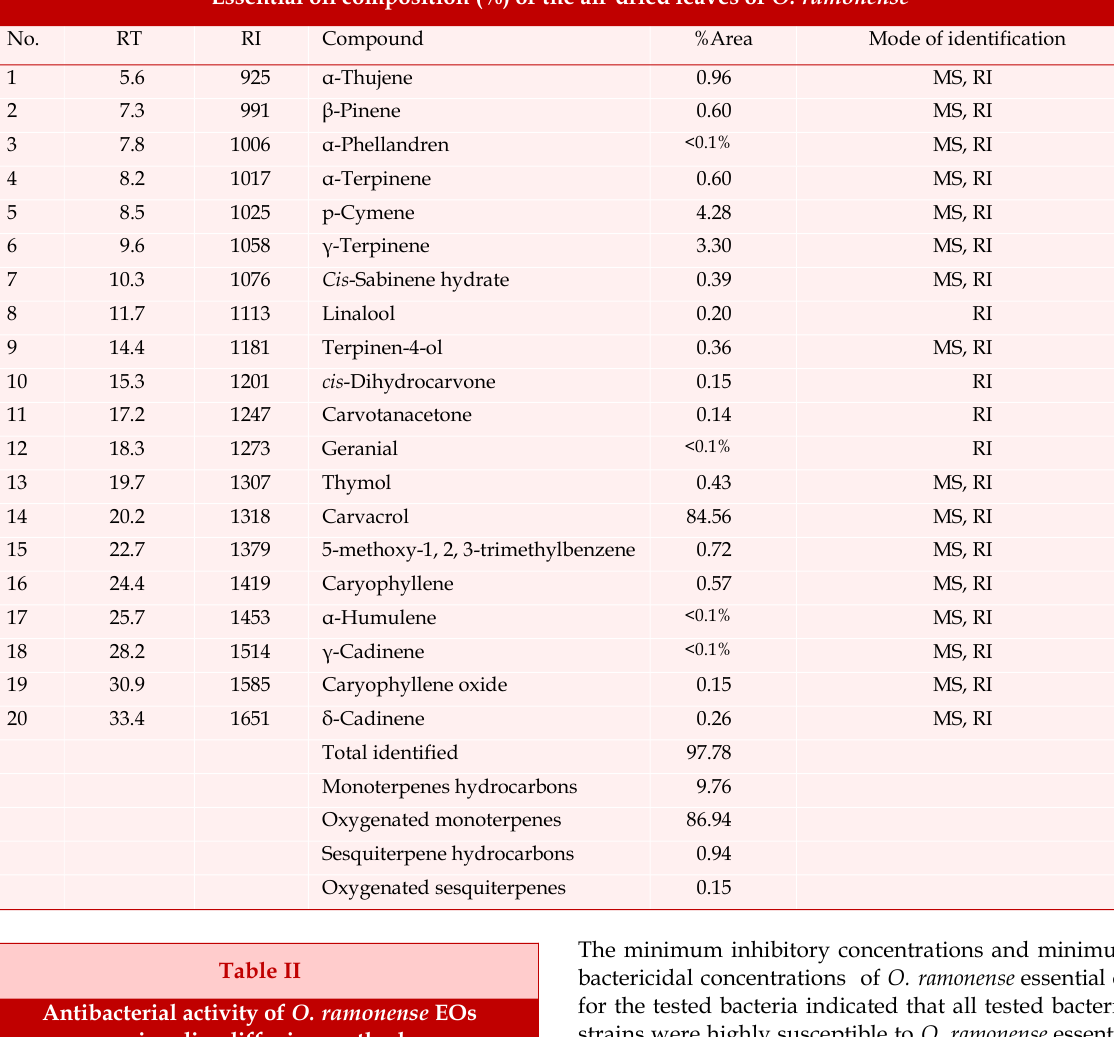
Essential oil composition (%) of the air-dried leaves of O. ramonense